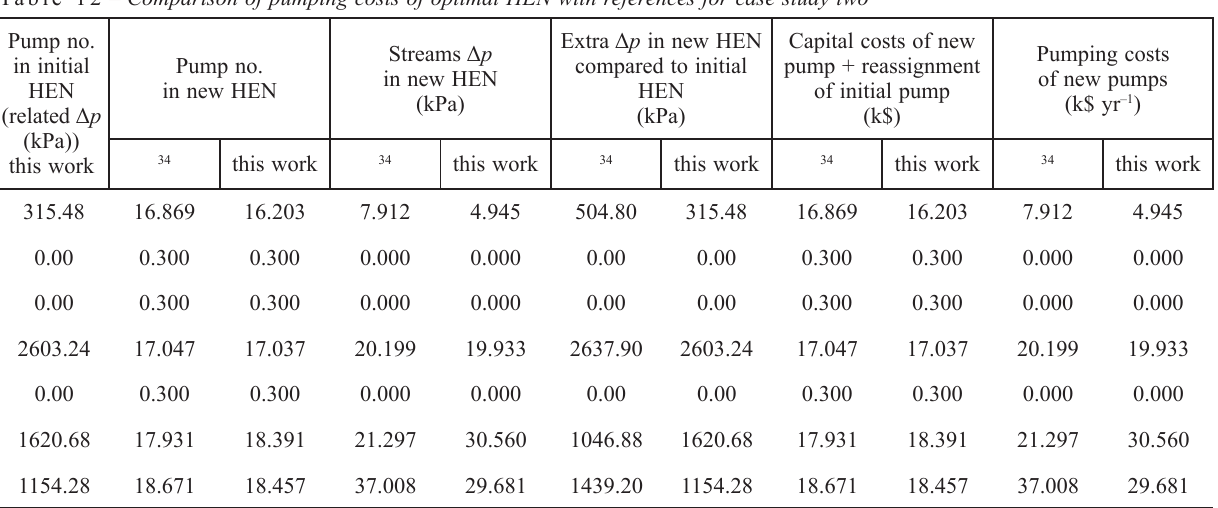
Table 12 – Comparison of pumping costs of optimal HEN with references for case study two Pump no. in initial Pump no. HEN in new (related Δ p (kPa)) this work